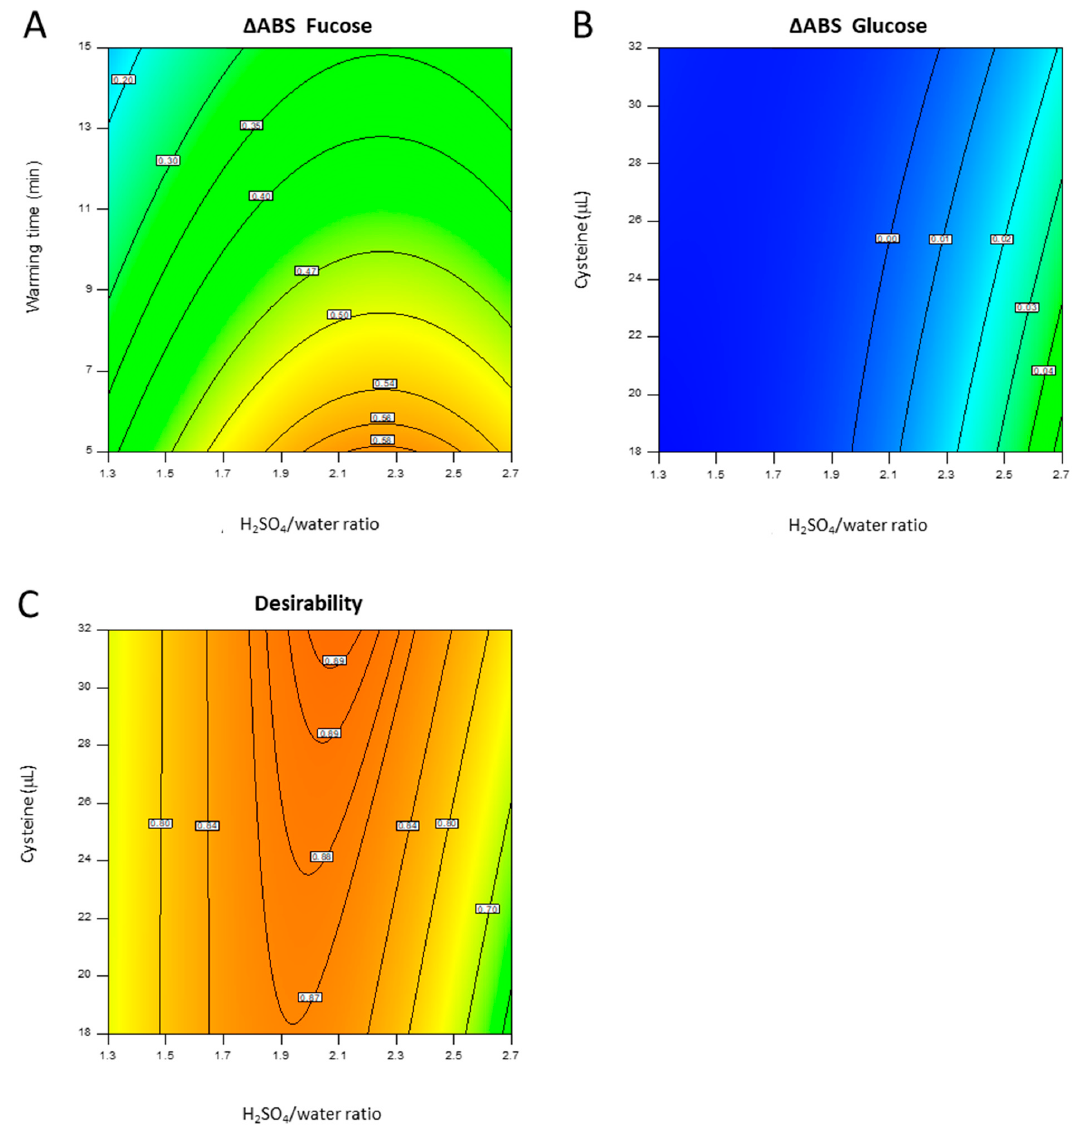
Figure 2. 2D contour plots for fucose response ( A ), glucose response ( B ) and for desirability obtained for 5 min warming time ( C ).